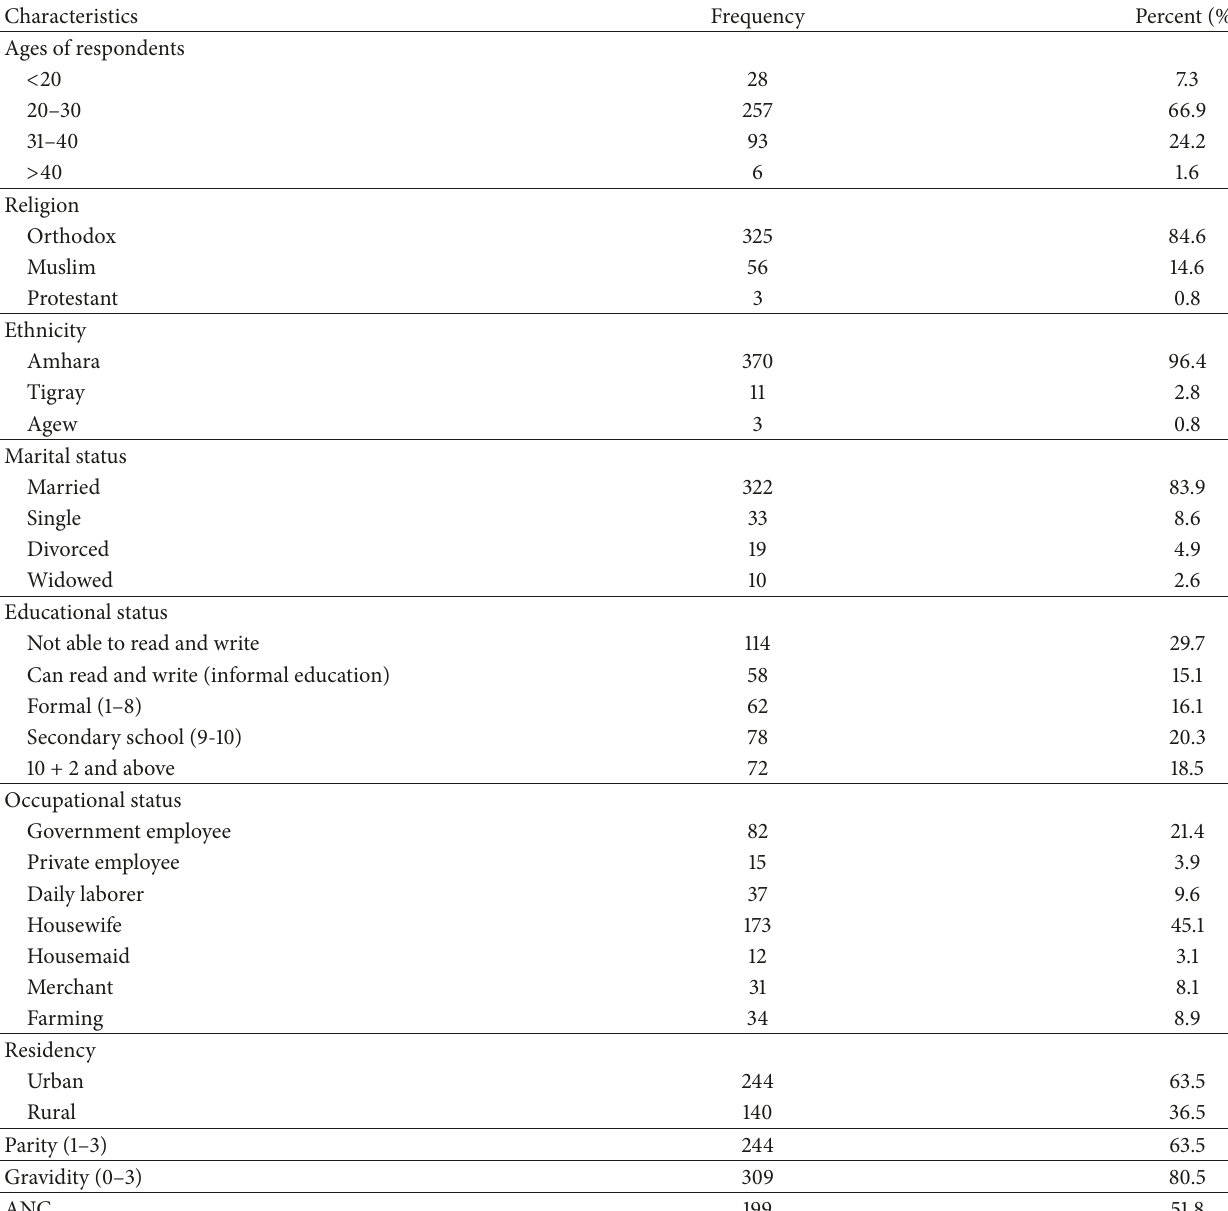
Table 1: Sociodemographic characteristics of the respondents in Dabat Health Center, Northwest Ethiopia, 2016. 𝑛 = 384 .